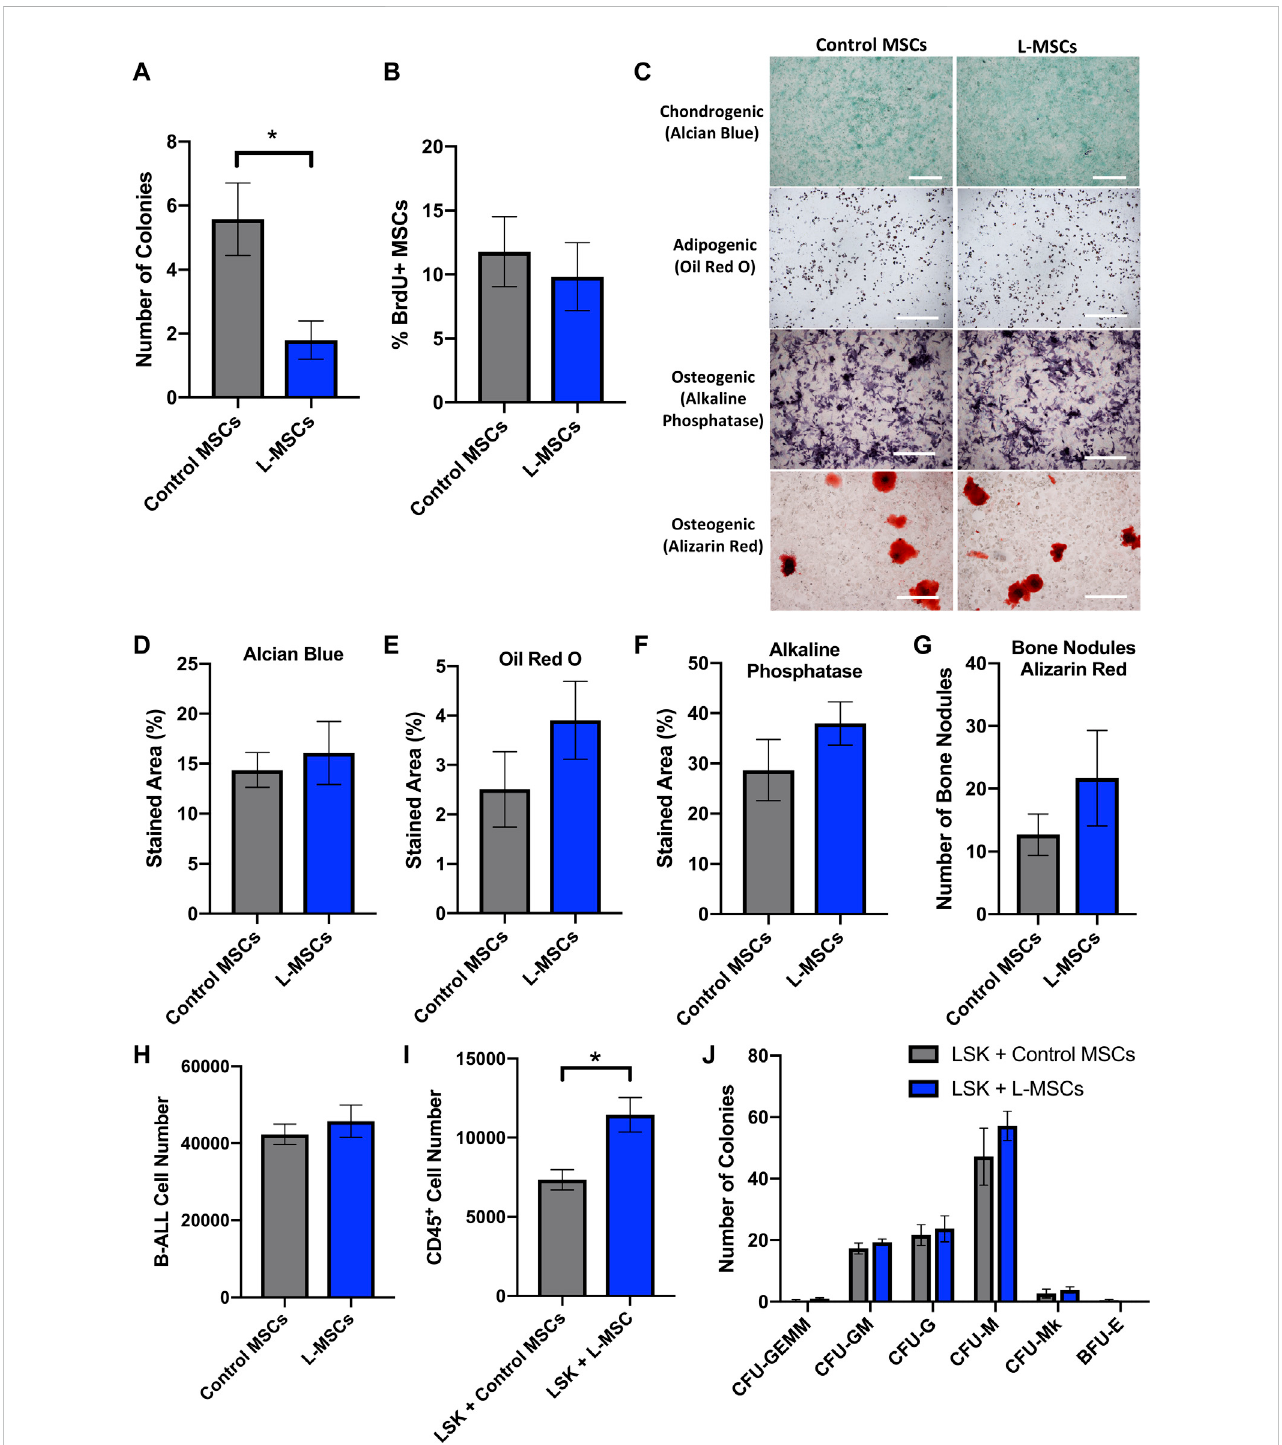
FIGURE 1 CellularcharacterizationofL-MSCsrevealsreducedself-renewalcapacityandincreasedpotentialtosupporttheexpansionofLSKcells invitro . (A) Quanti fi cationof thenumberofMSCCFU-Fcolonies( > 50cells)perwellafter14 daysinculture.Datawerecollatedfromthreeindependentexperiments(n=7). (B) Quanti fi cationofBrdU + MSCs isolated from the long bones of control or B-ALL mice. Data were collated from two independent experiments (n = 7). (C) Representative images showing Alcian blue, Oil Red O, alkaline phosphatase and Alizarin Red-stained cells following culture of control or L-MSCs in chondrogenic, adipogenic and osteogenic differentiationmedia. (D) Quanti fi cationofAlcianblue-stainedareafollowingchondrogenicdifferentiationofMSCsfor20-22days. (E) Quanti fi cationofOilRedO-stained areafollowingadipogenicdifferentiationofMSCsfor6days. (F) Quanti fi cationofalkalinephosphatase-stainedareaand (G) numberofAlizarinRed-stainedbonenodules followingosteogenicdifferentiationofMSCsfor13 daysand26 – 28 daysrespectively.Datafromdifferentiationassaysarepresentedasmean±SEM(n=3pergroup)and arerepresentativeoftwoindependentexperiments. (H) Numberofluciferase-expressingB-ALLcellsperwellfollowinga3